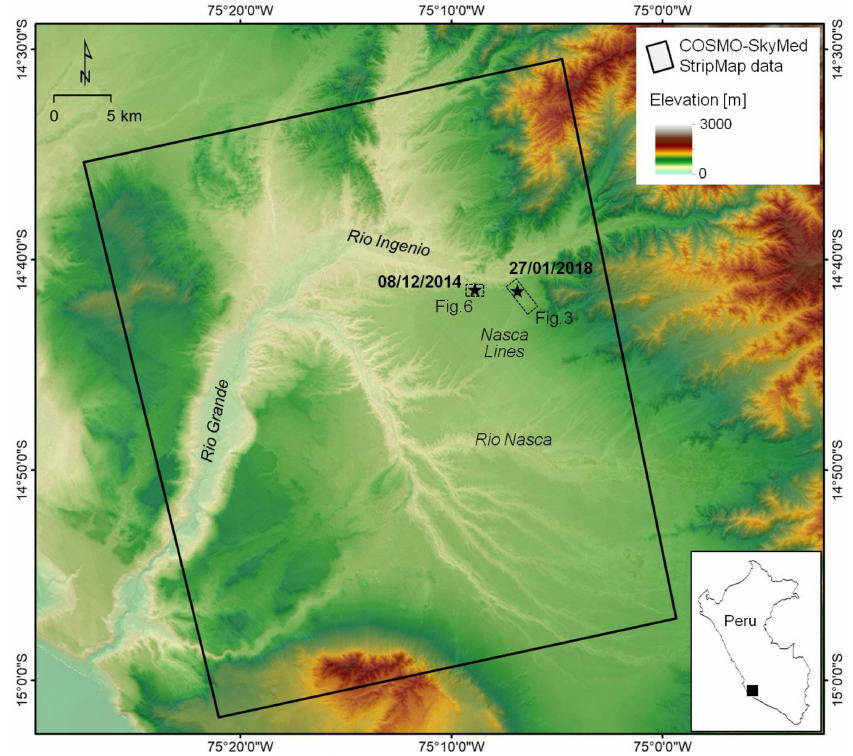
Figure 1. Location of the Nasca Lines region of interest in Peru on 30-m resolution NASA’s shuttle radar topography mission (SRTM) digital elevation model, with indication of the COSMO-SkyMed StripMap image footprint (black rectangle) and areas affected by the 2014 and 2018 events (black